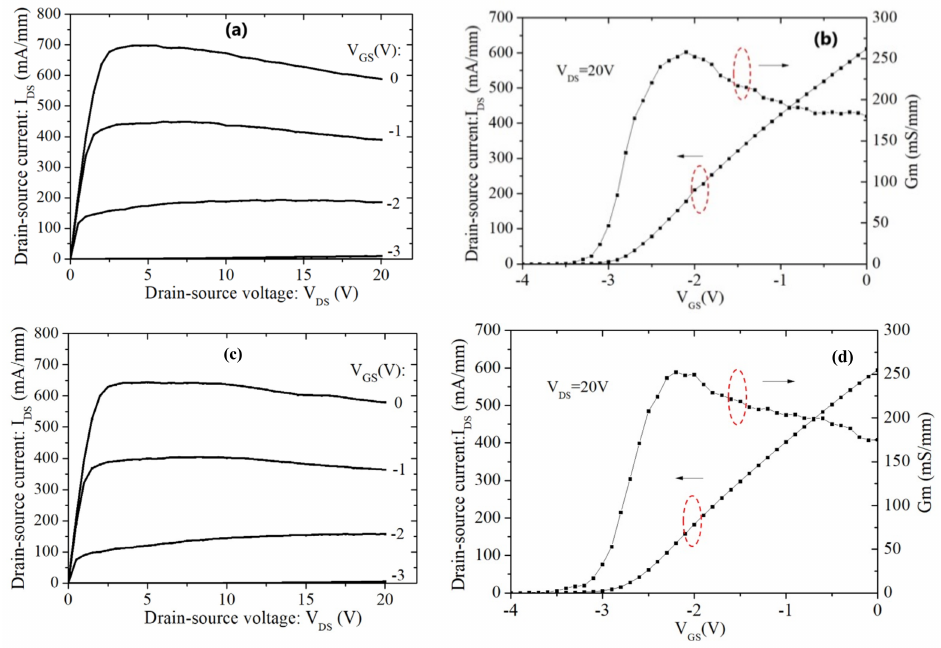
Figure 4. ( a ) I DS -V DS , and ( b ) I DS /G m -V GS characteristics of the 2 × 50 µ m GaN:C/EBL buffer device. ( c ) I DS -V DS , and ( d ) I DS /G m -V GS characteristics of the 2 × 50 µ m